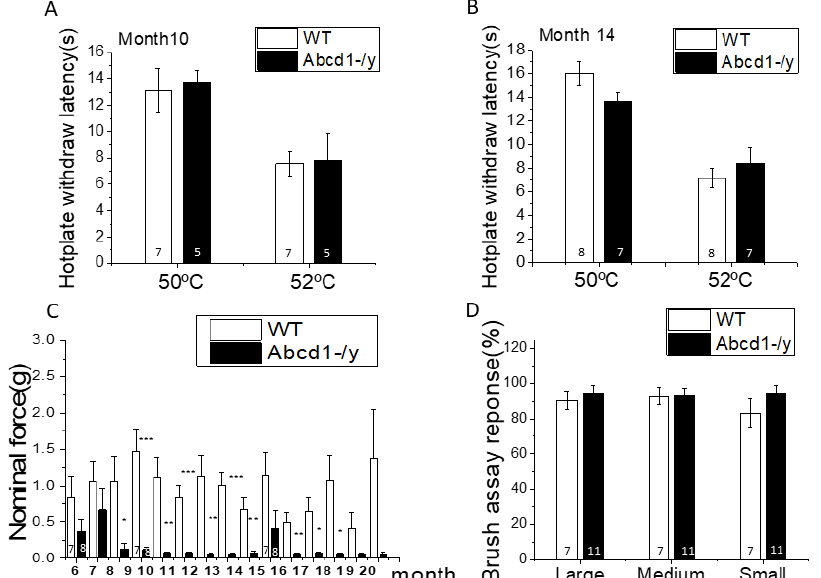
Figure 2. Abcd1 − /y mice exhibit mechanical but not thermal hypersensitivity. ( A ) Thermal sensitivity of Abcd1 − /y mice measured by hotplate testing at 10 months ( n = 7 for WT, n = 5 for Abcd1 − /y ). ( B ) Thermal sensitivity of Abcd1 − /y mice measured by hotplate testing at 14 months ( n = 8 for WT, n = 7 for Abcd1 − /y ). ( C ) Mechanical sensitivity of Abcd1-/y mice measured by Von Frey testing from 6 months until 20 months of age ( n = 7 for WT, n = 8 for Abcd1 − /y ). ( D ) Brush assay in 9–10-month-old mice ( n = 7 for WT, n = 11 for Abcd1 − /y ). Results were expressed as means ± SEM. * p < 0.05, ** p < 0.01, and *** p < 0.001 as compared with WT control.